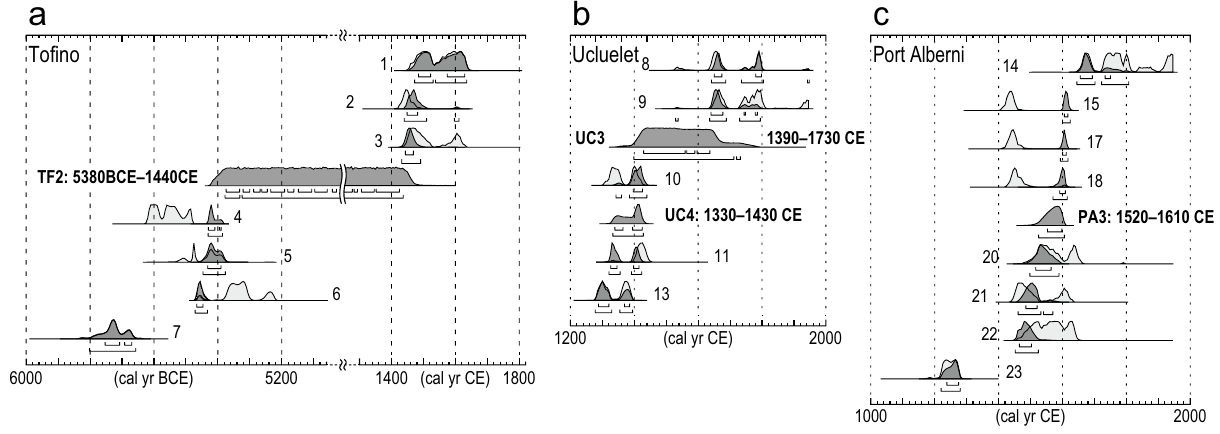
Figure 3. Estimates of the age of sand sheets TF2 ( a ), UC3 and UC4 ( b ), and PA3 ( c ). Ages of plant macrofossils and insects were used for age estimation. Constrained ages (2σ range) were calculated using OxCal 4.4 60,61 with the IntCal20 62 . Age estimation followed the procedure of Lienkaemper and Bronk Ramsey (2009) 58 . Sample numbers correspond to the numerical superscripts shown in Fig. 2 and listed in Supplementary Table S1. Three anomalous ages, Nos. 12, 16, and 19, were excluded from the age estimation because they are younger or older than those obtained from horizons above and below them. The light and dark gray distributions indicate probability distribution functions (PDFs) of calibrated and modelled ages by OxCal, respectively. Horizontal bars below PDFs indicate 1σ and 2σ ranges of modelled